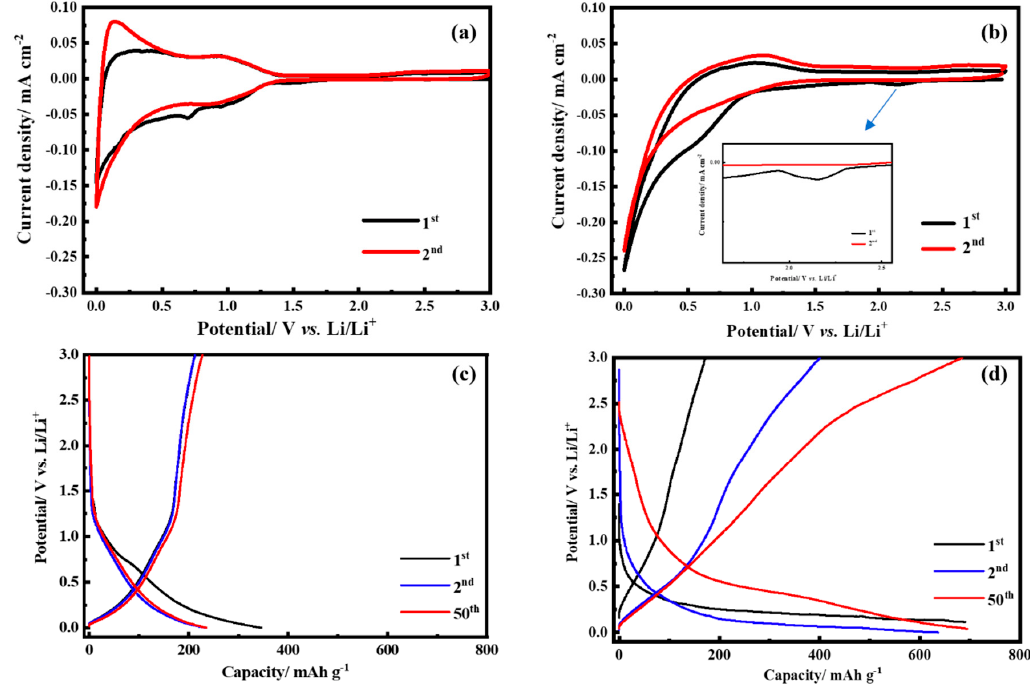
Figure 2. The cyclic voltammetry (CV) measurements of ( a ) Super-P (SP) and ( b ) MA electrodes at a scan rate of 0.1 mV s − 1 . The charge and discharge profiles of ( c ) the SP and ( d ) the MA electrodes at 0.1 C at the first and the 50th cycle.